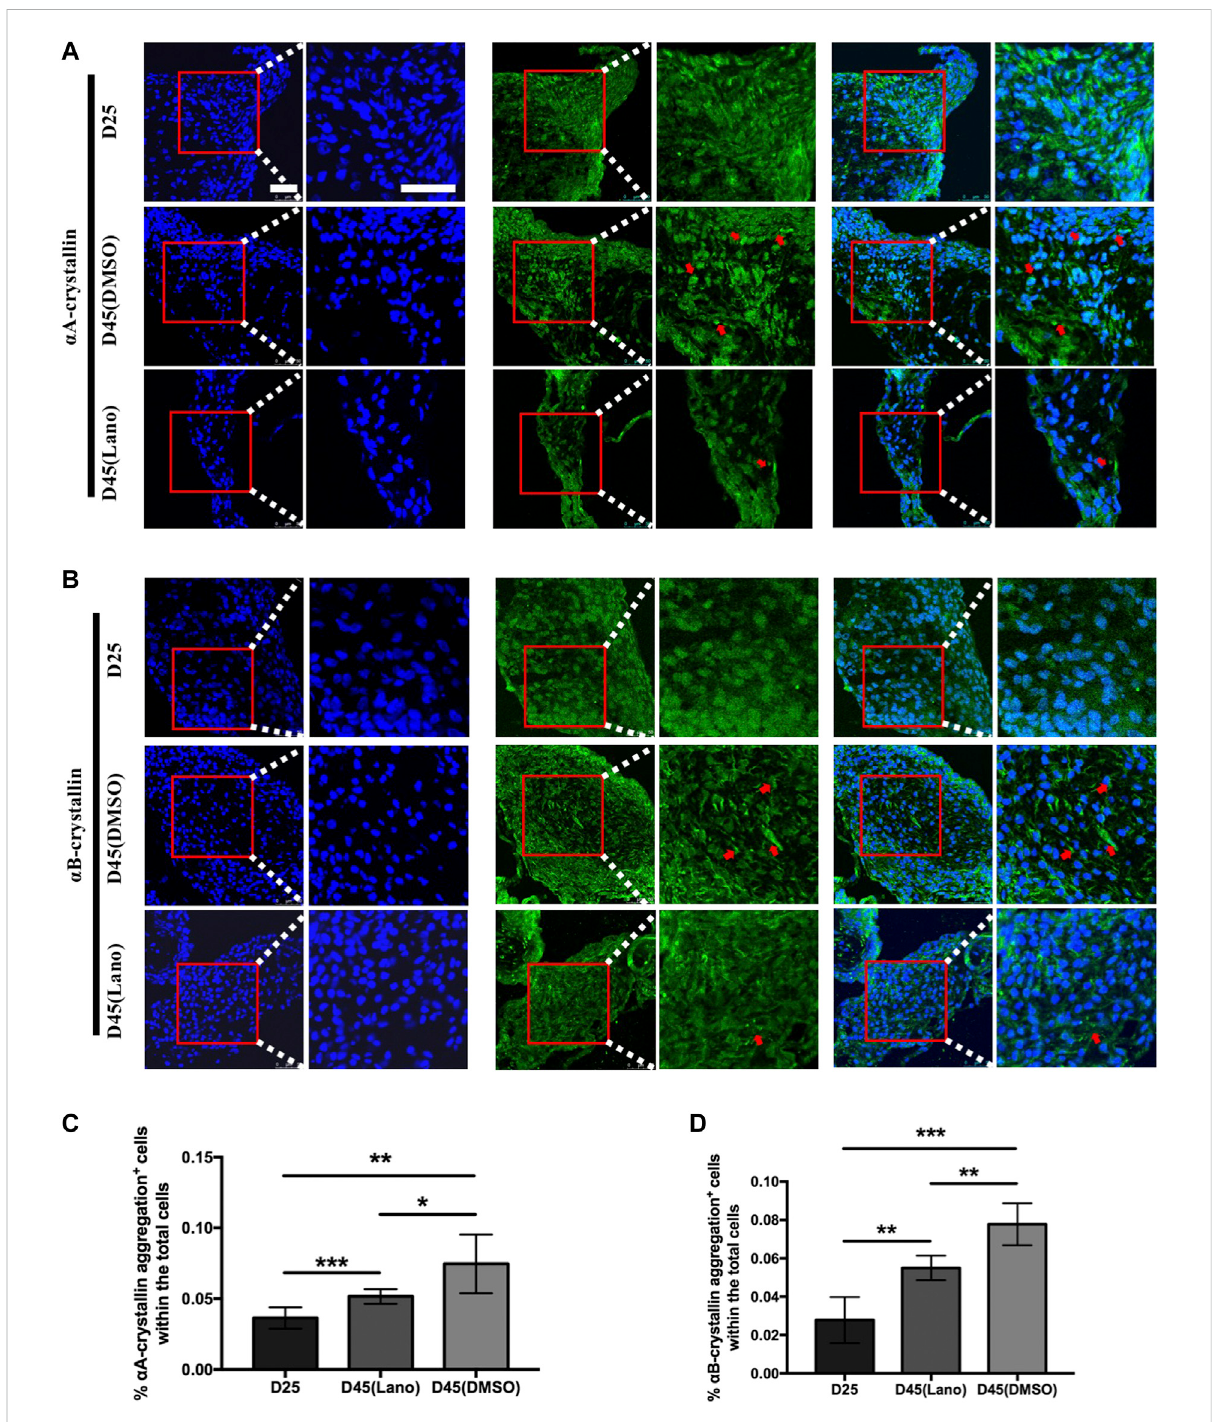
FIGURE 5 Protein aggregation in control and lanosterol treated LBs in LB slices staining. (A,B) Similar with Figure 4, cells containing α A-crystallin or α B- crystallinproteinaggregation(redarrows)weremoreabundantincontrolcloudyLBsonD45comparedwithlanosteroltreatedLBsonD45,andware nearly absent in all LBs on D25. (C,D) Quanti fi cation data showed that more cells containing protein aggregations were observed in control control LBsonD45comparedwithcontrolLBsonD25andlanosteroltreatedLBsonD45.Barsrepresentmean±SD.* p < .05,** p < .01,*** p < .001.Bar: 50uM. DMSO, dimethyl sulfoxide. Lano,